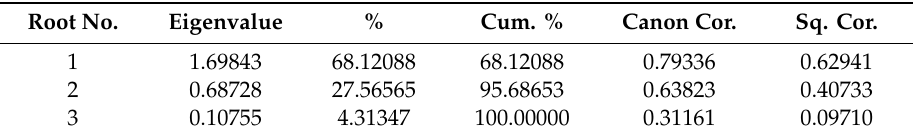
Table 5. Eigenvalues and canonical correlations.